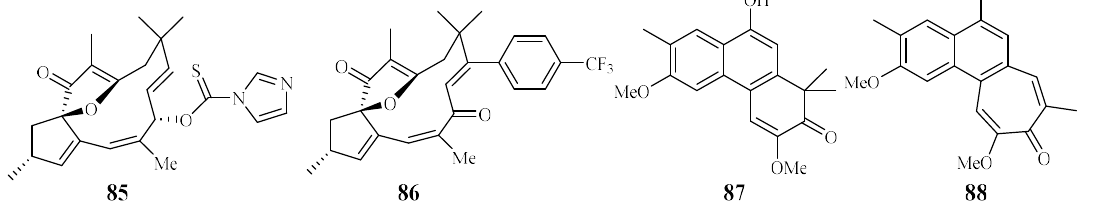
Figure 16. Compounds from Euphorbiaceae plants.